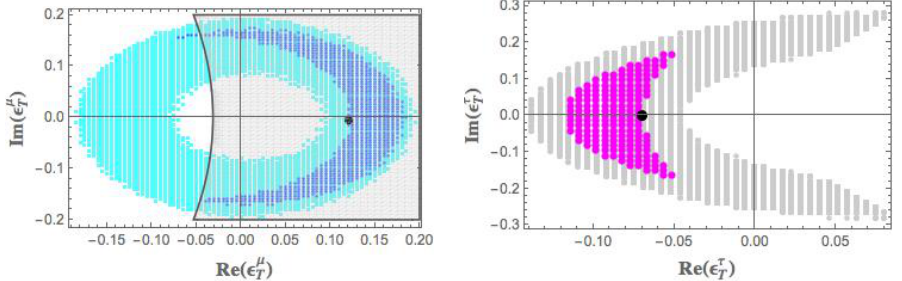
Figure 6 . Parameter space of (cid:15) (cid:22) (lighter regions). The darker regions correspond to (cid:31) 2 < 1 : 0. In (cid:15) (cid:22) using the Belle measurement of R e(cid:22) [17]. The black dots are the values ~ (cid:15) ‘ as benchmark